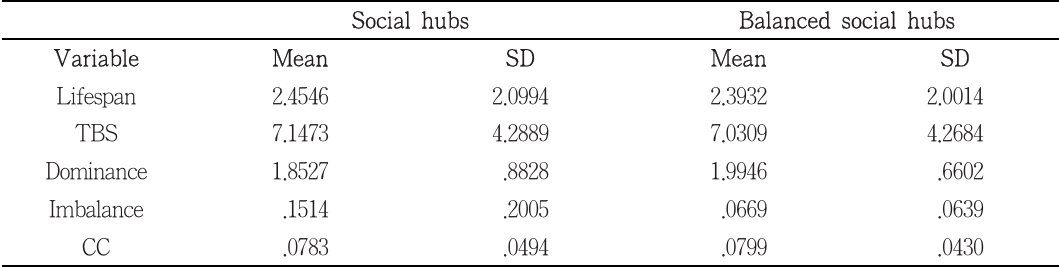
<Table 3> Descriptive analysis of social hubs and balanced social hubs